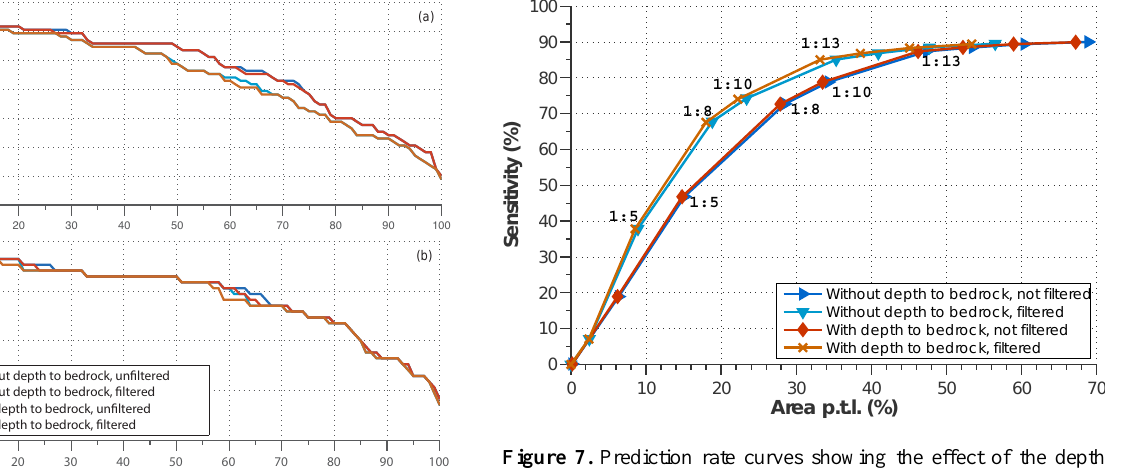
Figure 7. Prediction rate curves showing the effect of the depth to bedrock data and the filtering procedure on the areas prone to landslides. The cross-sectional angle threshold varies from 1 : 1 to 1 : 22. The values of the cross-sectional angle thresholds are shown for some points along the prediction rate